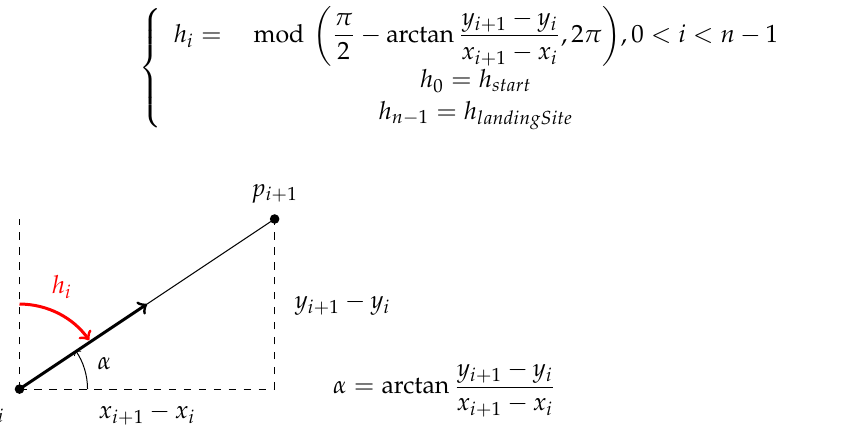
Figure 4. Heading computation: From the position of the points p i and p i + 1 , the orientation angle α is computed, followed by the heading h i